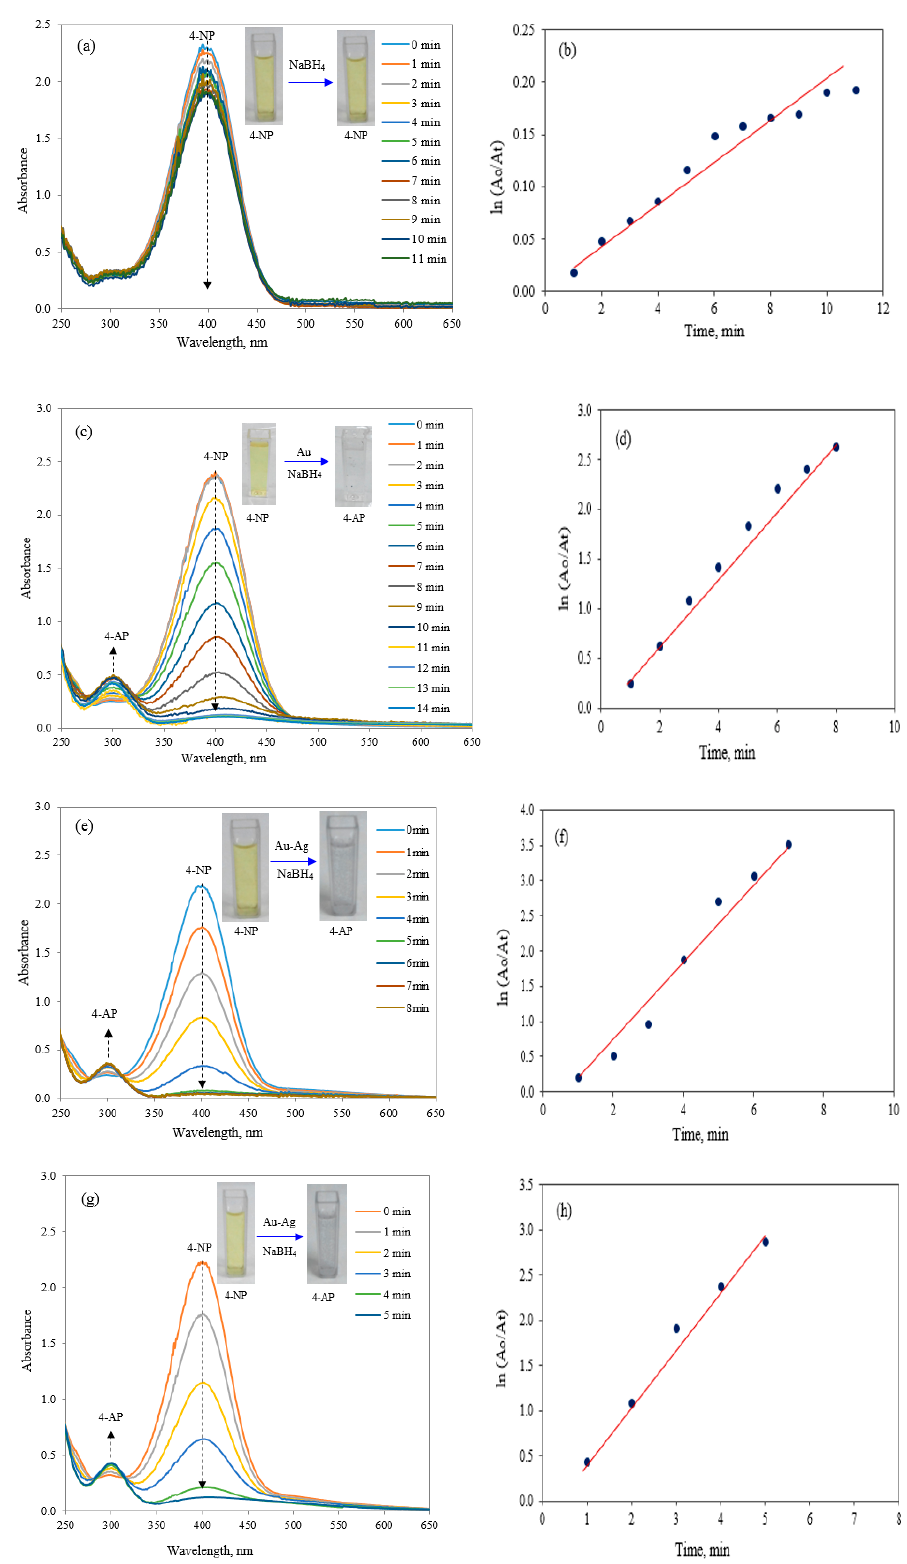
Figure 9. Absorption spectra of 4 ‐ NPreduced by ( a ) NaBH 4 only. NaBH 4 in the presence of ( c ) Au NPs, ( e ) 2.0 mL Au seeds volume of Au ‐ Ag NPs, and ( g ) 5.0 mL Au seeds volume of Au ‐ Ag NPs and corresponding ln(A 0 /A t ) versus time plot for the determination of rate constants for ( b ) NaBH 4 , ( d ) Au NPs, ( f ) 2.0 mL Au seeds volume Au ‐ Ag NPs, and ( h ) 5.0 mL Au seeds volume Au ‐ Ag NPs.